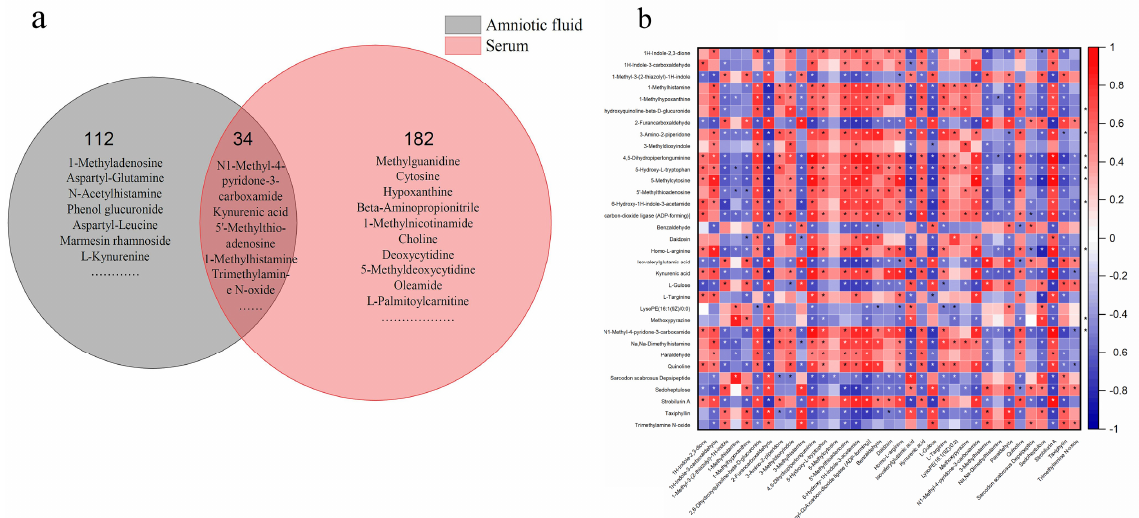
Figure 6. The common differential metabolites in serum and AF samples and their association. ( a ) The Venn diagram of common metabolites in serum and AF samples. ( b ) The correlation heat map of metabolites. The vertical axis: differential metabolites in AF; the horizontal axis: differential metabolites in serum samples. The red represents positive association; the blue represents negative association. The darker the color, the stronger the correlation between the two kinds of samples. The asterisk meant the statistical significance ( p <